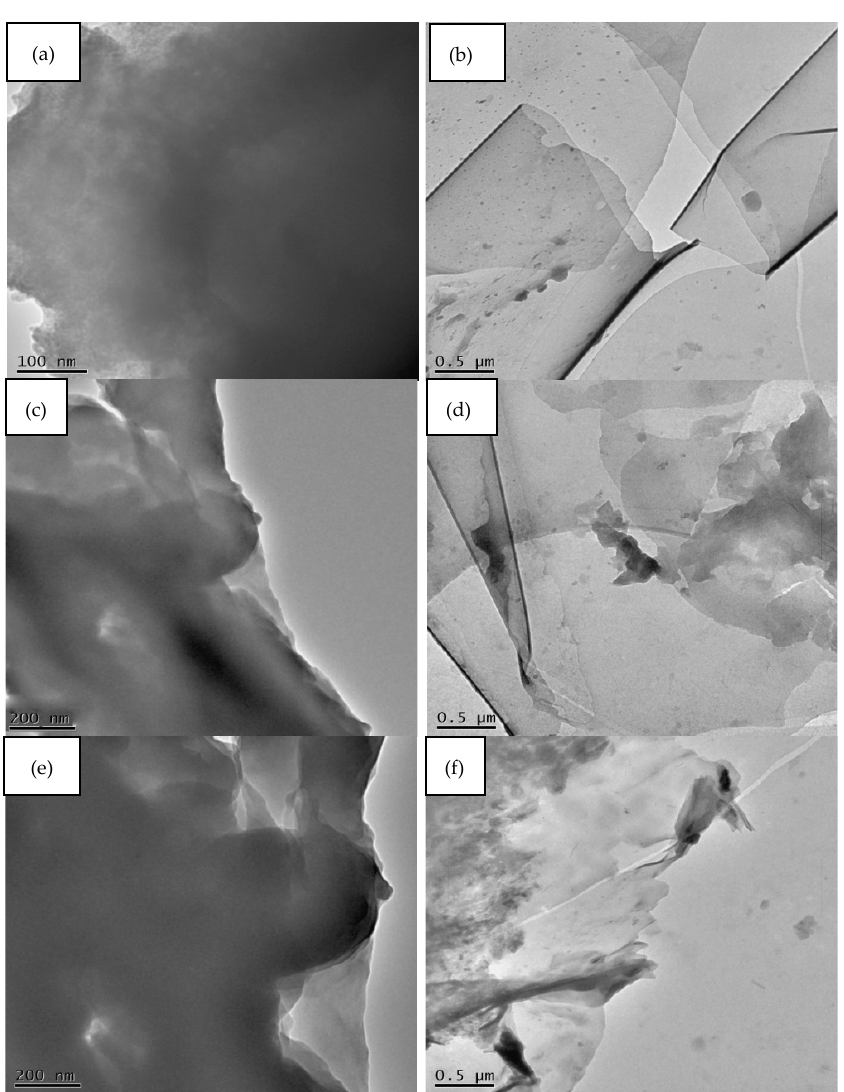
Figure 9. TEM images: ( a , c , e ) PU/GNP; ( b , d , f ) PU/GO nanocomposites with loadings of 0.25 wt. %, 0.5 wt. %, and 0.75 wt. %, respectively, with a magnification scale of 200 µm and 0.5 µm.